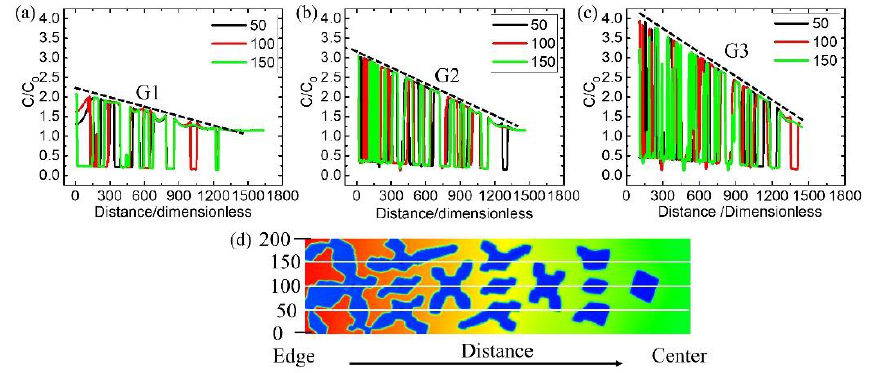
Figure 9. Simulation results about the solute concentration distribution under different temperature gradient ( a ) 0.230 °C/mm, ( b ) 0.442 °C/mm and ( c ) 0.657 °C/mm along the three white lines in ( d ).